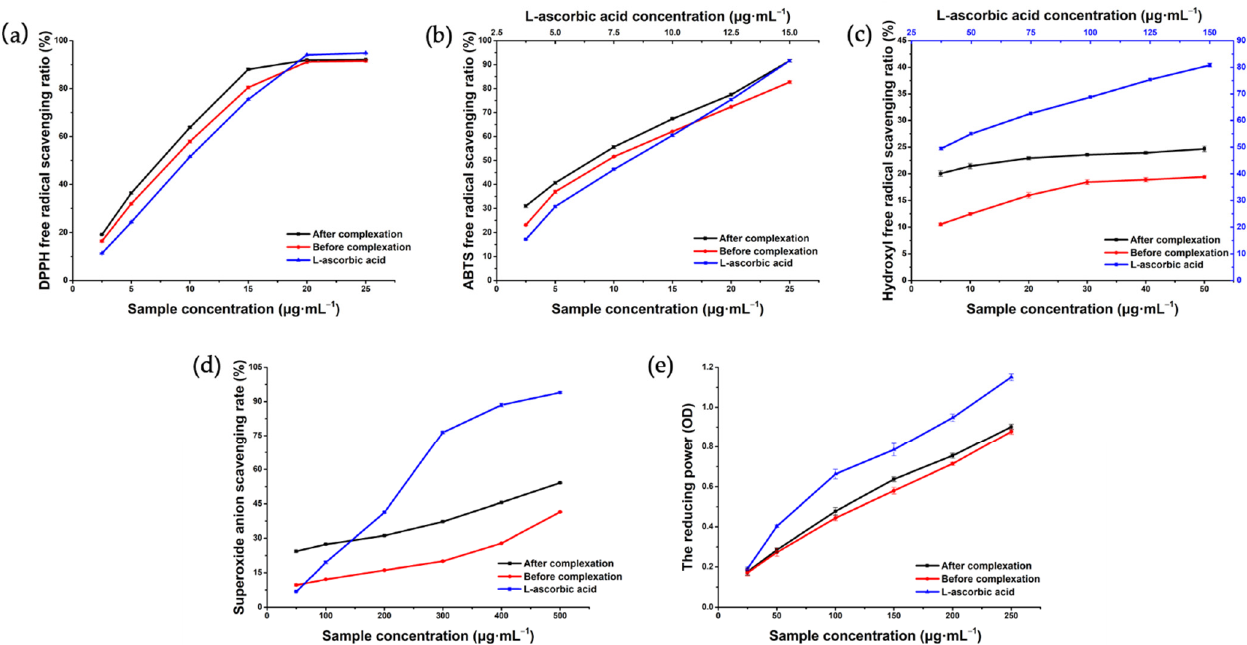
Figure 11. Antioxidant test of Hyp and Hyp–2H- β -CD. ( a ) DPPH radical scavenging activities; ( b ) ABTS radical scavenging activities; ( c ) hydroxyl radical scavenging activities; ( d ) scavenging activity for superoxide anion radicals; ( e ) the reducing power.